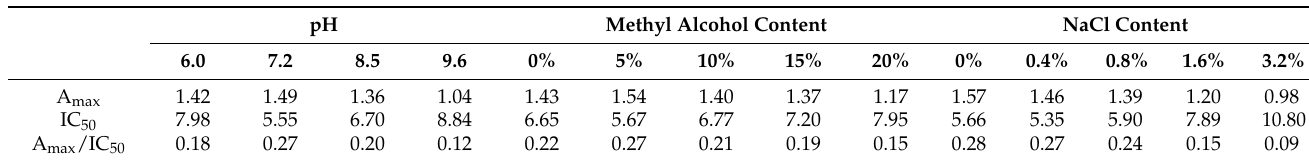
Table 2. Optimization of the pH, methanol content and the NaCl content on endosulfan, through the ic-ELISA assay.